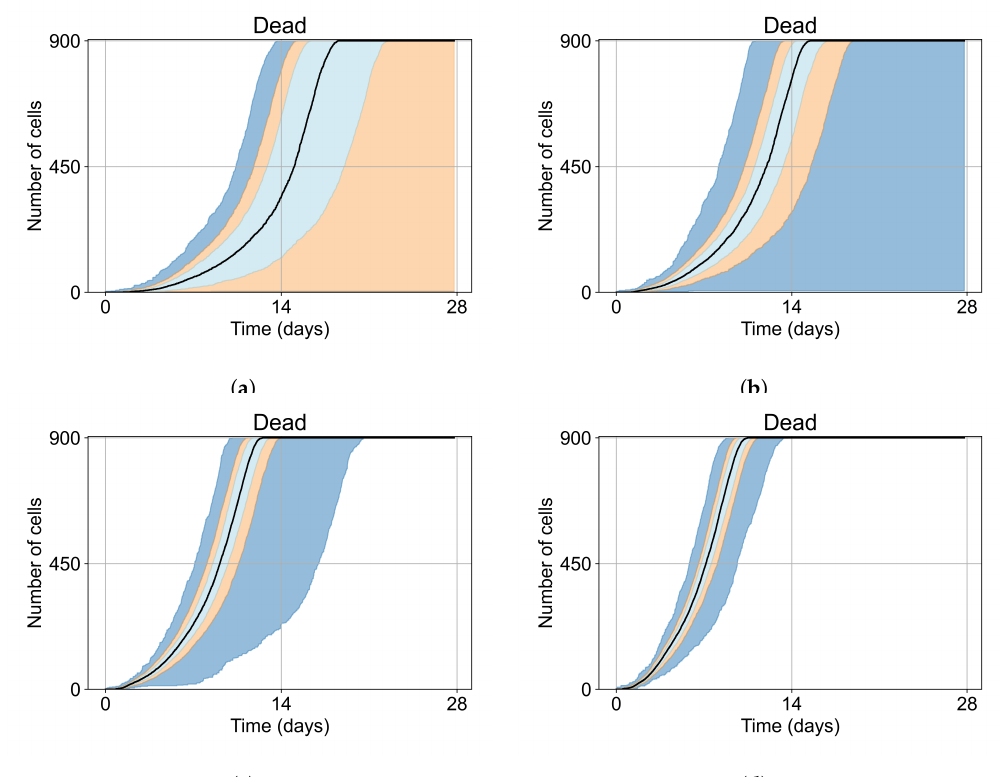
Figure A2. Dead cell populations for 400 replicas of Sego et al.’s model performed by us [24]. In all the cases, the medians of simulation replicas are in black lines, the 0th to 100th quantiles are shaded as dark blue, 10th to 90th shaded in orange, and the 25th to 75th as light blue. ( a ) Simulations start with 1 initially infected cell and 7 simulations result in failure to infect (1.75% of replicas), the 90th quantile includes the upper bound of the number of cells. ( b ) Simulations start with 2 initially infected cells where 5 simulations result in failure to infect (1.25%), the 100th quantile includes the upper bound of the number of cells. ( c ) Simulations start with 5 initially infected cells. ( d ) Simulations start with 10 initially infected